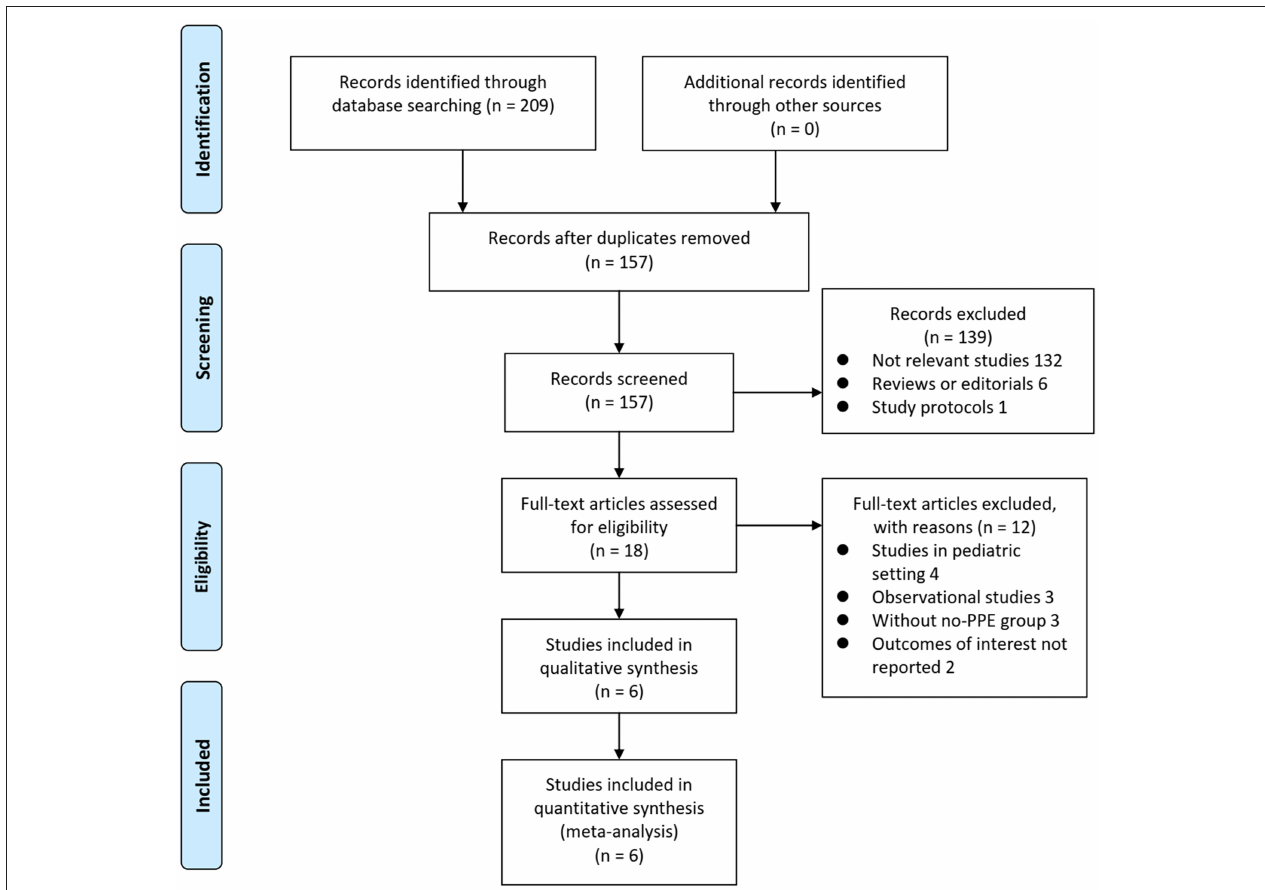
FIGURE 1 | Flowchart of literature